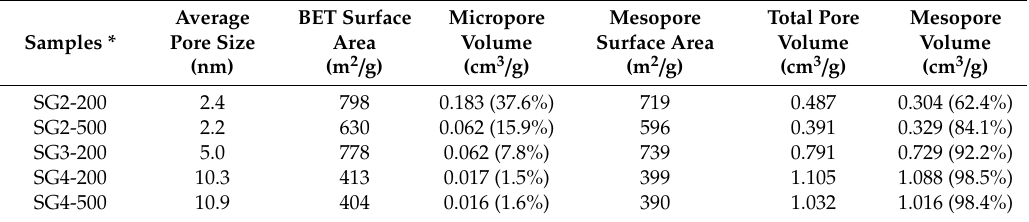
Table 3. Porous properties of porous silica glass synthesized in this